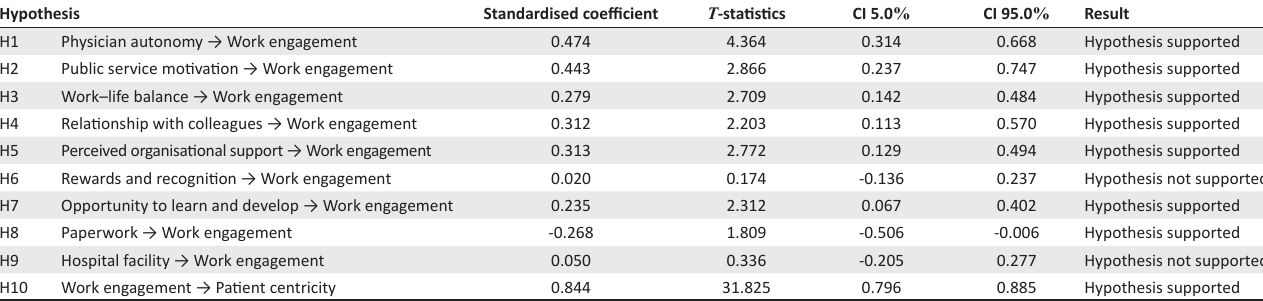
TABLE 3: Hypothesis test result.